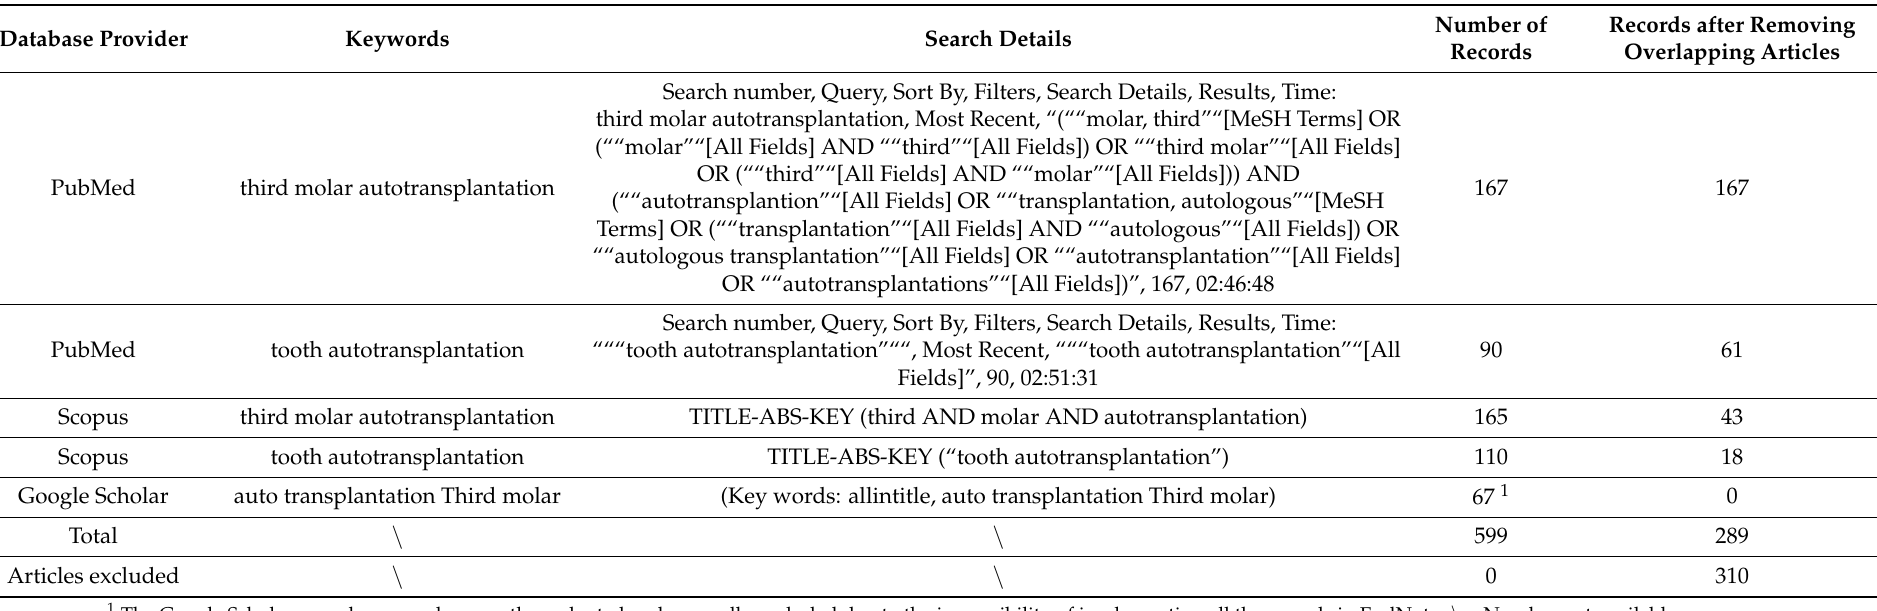
Table 1. Complete overview of the search methodology. Records identified by databases and Google Scholar: 599; Records after the application of the initial eligibility criteria: 249; Articles deemed potentially eligible: 180; Articles after the application of the inclusion and exclusion criteria: 78; Articles selected for qualitative analysis: